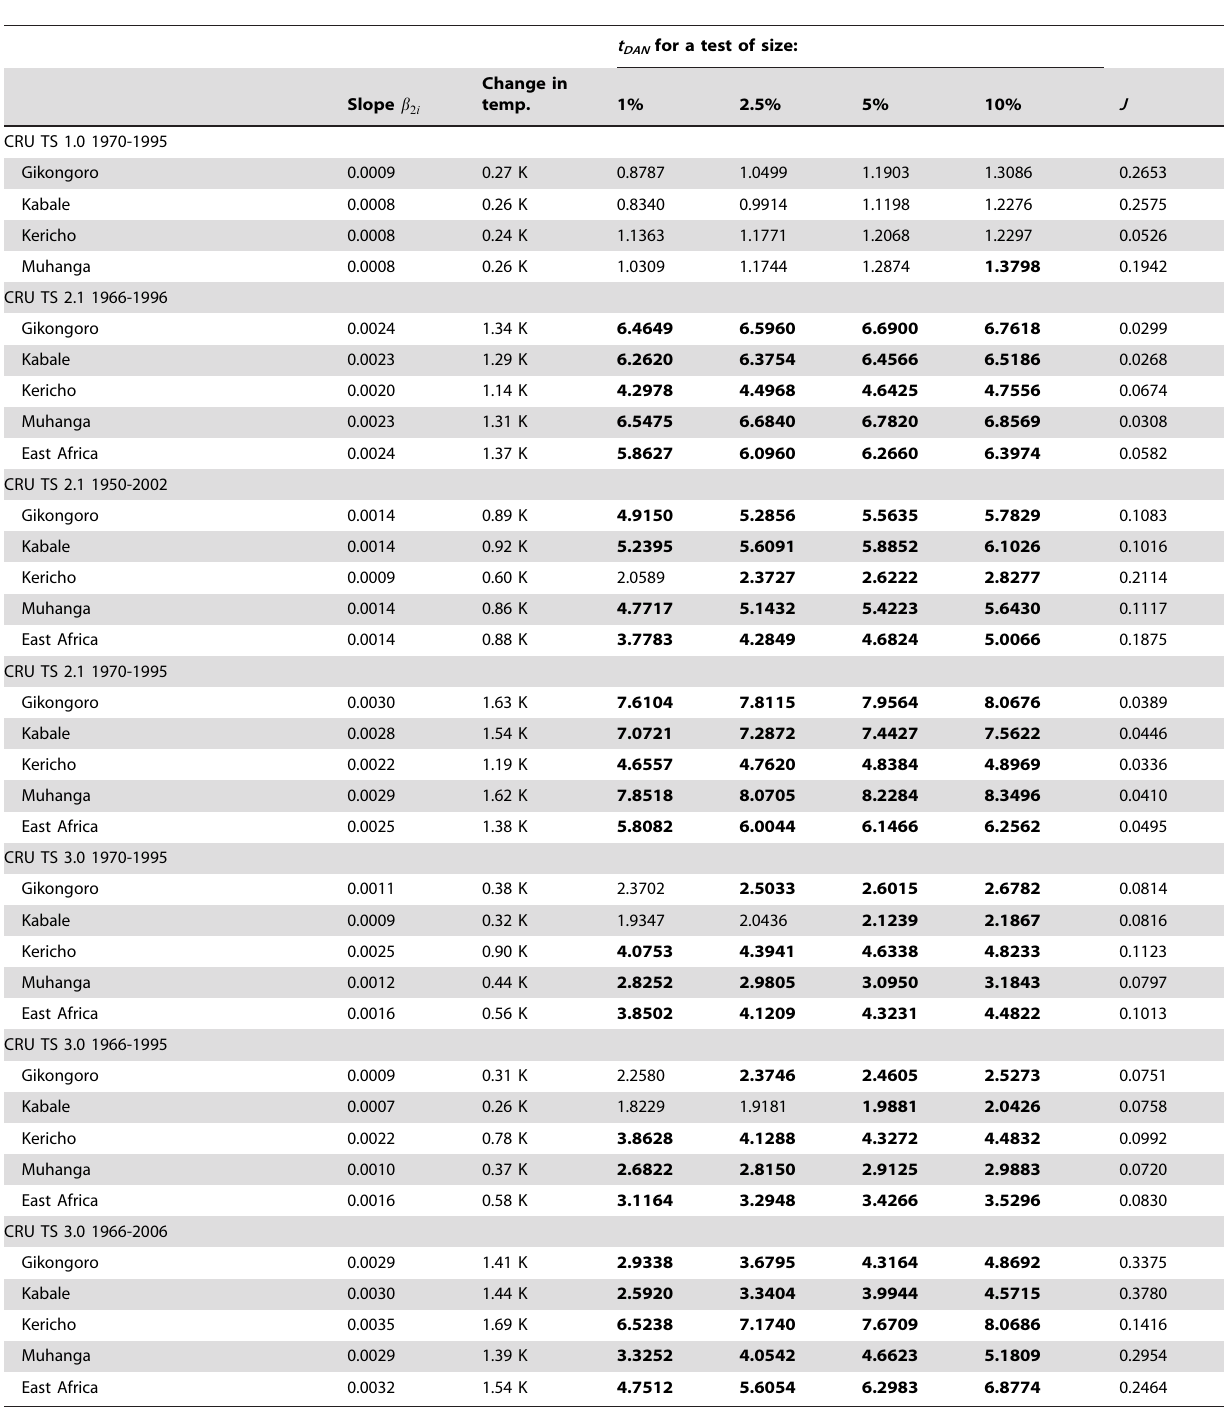
Table 2. Vogelsang Trend Tests for Deseasonalized CRU Temperature Series.